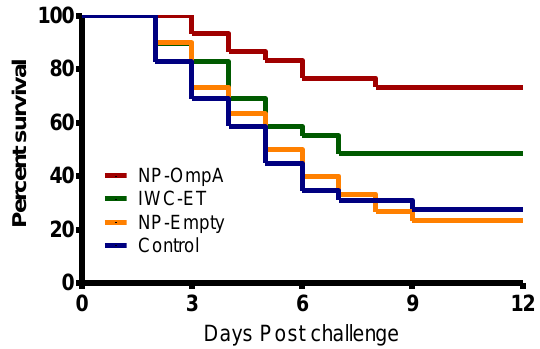
Figure 8. Kaplan Meyer’s survival analysis of fish vaccinated against E. tarda using the NP-rOmpA, IWC-ET, and NP-Empty vaccine together with control fish. Mortality in the IWC-ET, NP-Empty, and control groups started two days post challenge (dpc), while in the NP-rOmpA group it started 3 dpc. The highest post-challenge survival proportion (PCSPs) was from the NP-rOmpA group (PCSP = 73.33%), followed by the IWC-ET group (PCSP = 48.28%), while the NP-Empty (PCSP = 23.33%) and control groups (PCSP = 27.59%) had the lowest PCSPs. There was a significant difference ( p = 0.0396) in PCSP between the NP-rOmpA and IWC-ET groups. No significant difference ( p = 0.989) was detected in PCSPs between the NP-Empty and control